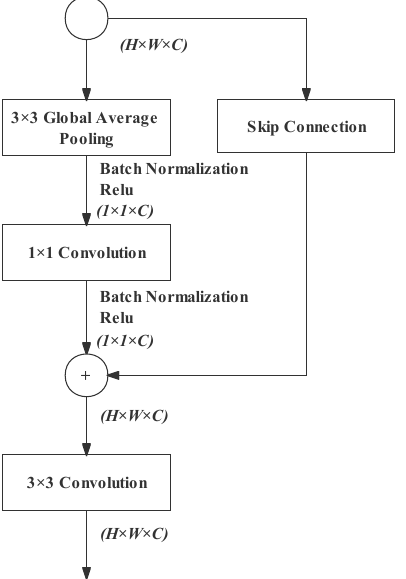
Figure 9. Context-embedding